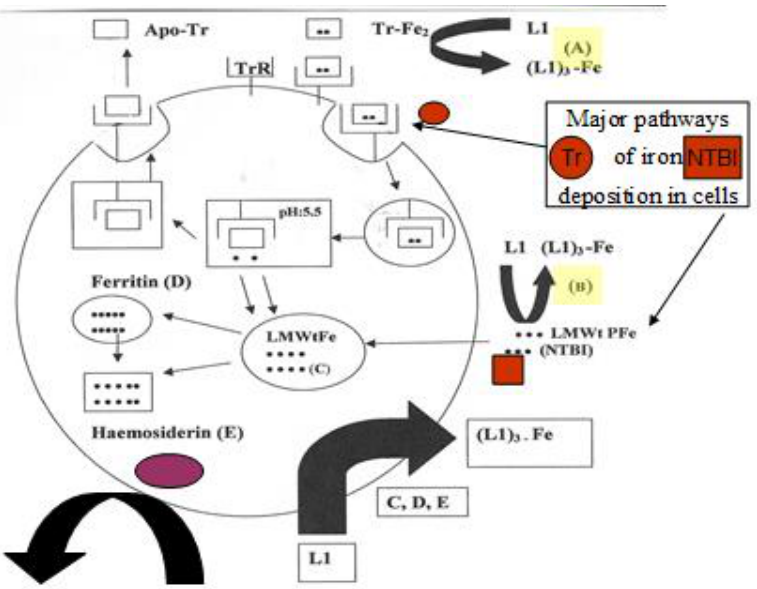
Figure 6. Iron mobilization by deferiprone (L1) from plasma and from cells in iron overloading conditions. Deferiprone can prevent iron accumulation in cells by mobilizing ( A ) transferrin bound iron (Tr-Fe2) and ( B ) non-transferrin bound iron (NTBI) found in plasma. Deferiprone can also mobilize intracellular iron from the ( C ) low molecular weight iron pool (LMWtFe), ( D ) ferritin and ( E ) hemosiderin. (Tr R: transferrin receptor; Apo-Tr: apotransferrin). Transferrin returns to plasma following the intracellular iron release. During the period of cellular entry transferrin is not involved directly in the iron delivery to iron-containing proteins.